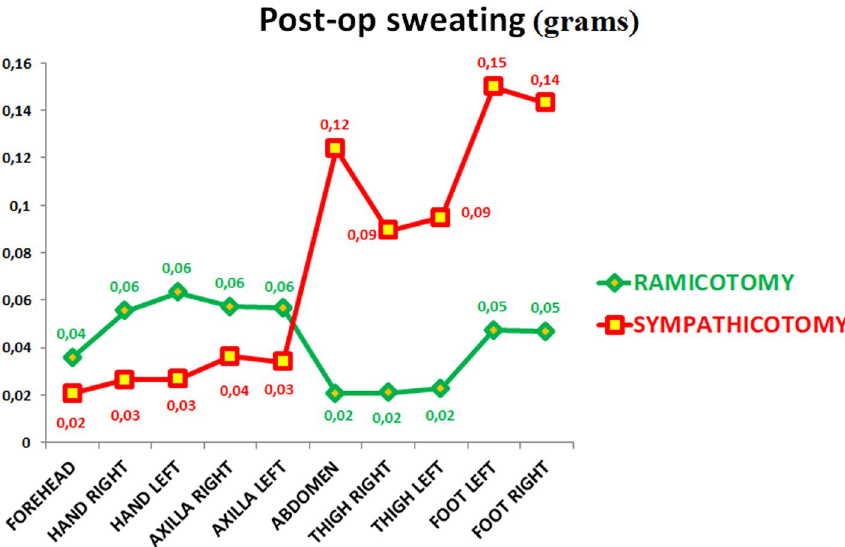
Figure 3. Postoperative sweating in different anatomical areas. Please notice some residual sweating in the partially sympathetically denervated areas in the RY, while there is almost none in the sympathicotomy. In addition, there is an increase in sweating in the abdomen, thighs, and feet in this last group that does not happen in the first group.